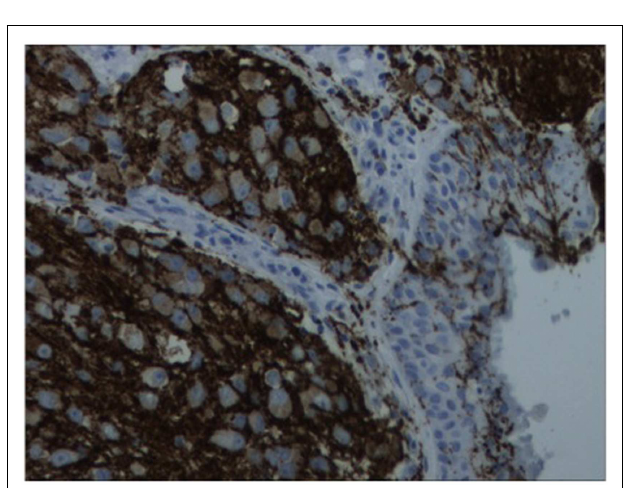
FIGURE 4 | Immunohistochemistry of lesion for synaptophysin (characteristically stains positive in esthesioneuroblastoma).